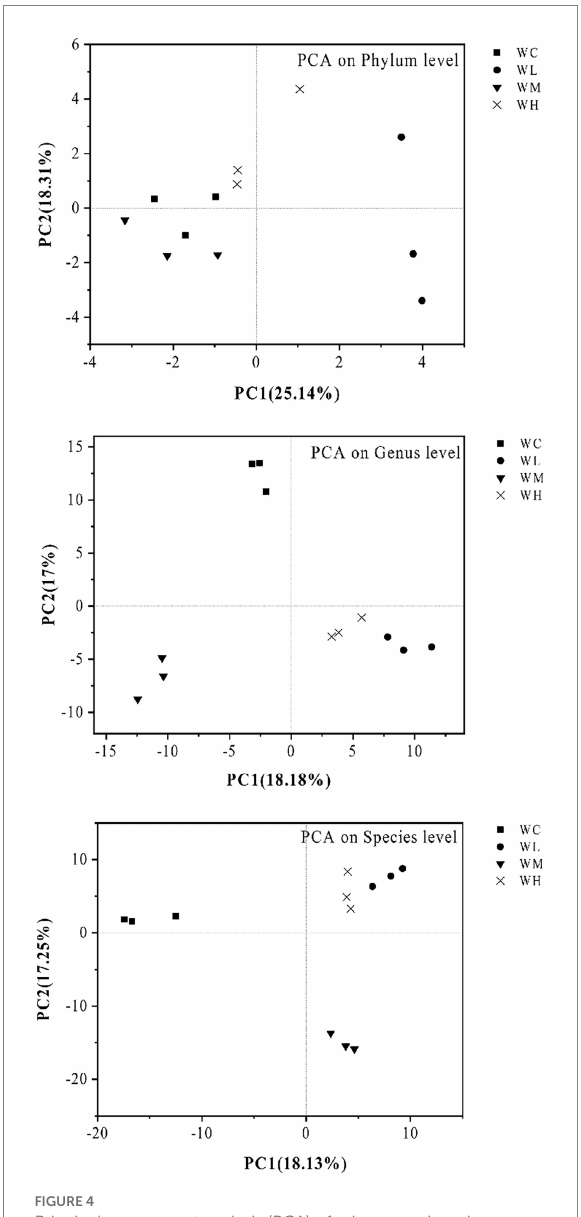
FIGURE 4 Principal component analysis (PCA) of microorganisms in aquaculture water of zebrafish. WC, WL, WM, and WH indicate four culture water treatments with different concentrations of AVH-AgNPs: 0, 6.23, 9.35, and 18.70 μ g/l,